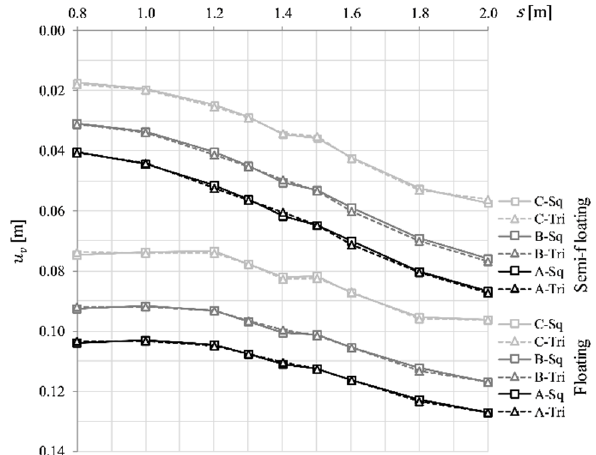
Figure 9. Settlement ( 𝑢 (cid:3049) ) computed in points A, B and C (Figure 1) with increasing centre-to-centre spacing ( 𝑠 ) for a square (Sq) and triangular (Tri) pile arrangements. Both floating and semi-floating pile